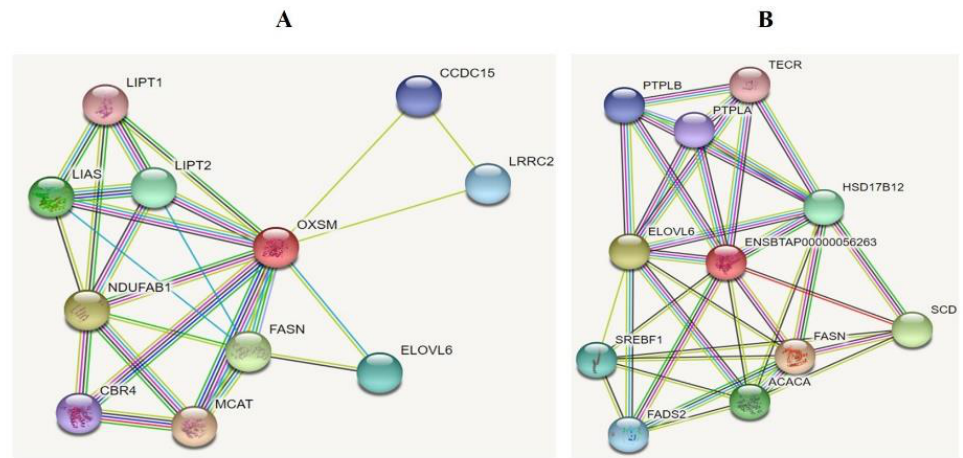
Figure 17. ( A , B ) String interaction of different fat metabolism-related genes of Bos